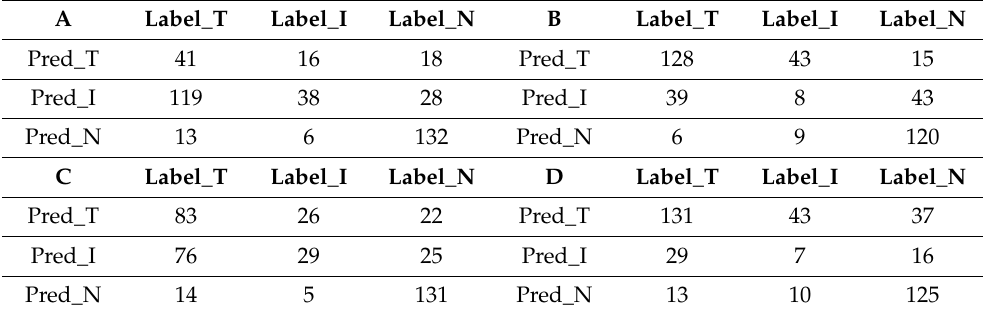
Table 1. Confusion matrices of four endoscopists. T, I, and N denote tumor, inflammation, and normal, respectively.